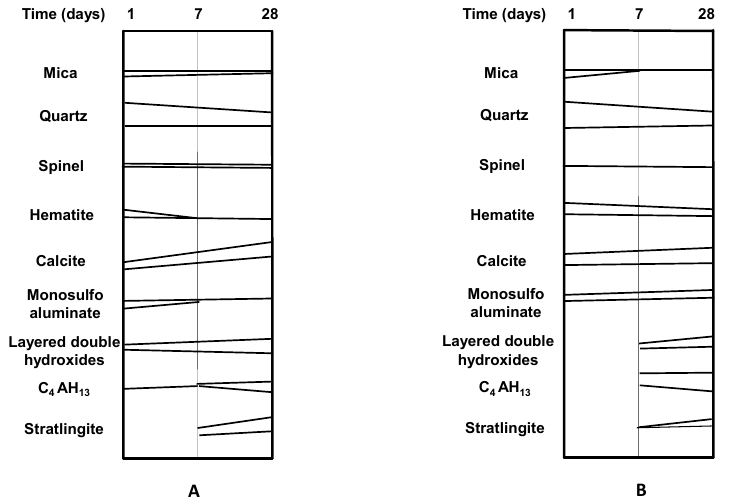
Figure 3. Mineralogical evolution of coal mining waste by XRD; ( A ) activated at 600 °C/2 h; ( B ) activated at 900 °C/2 h.